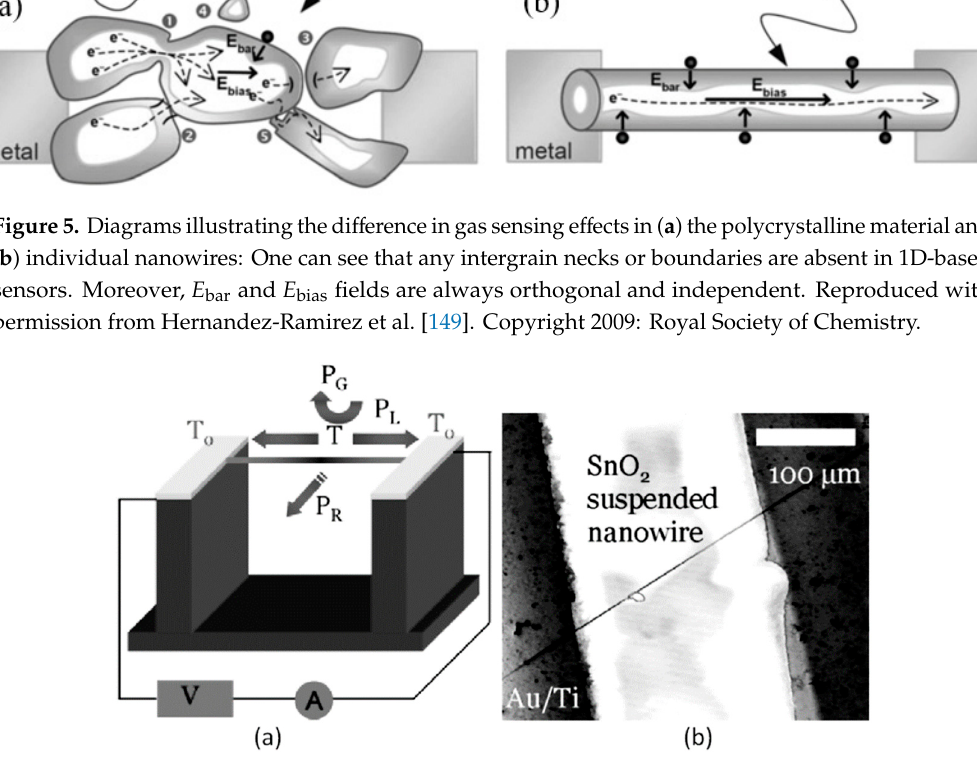
Figure 7. Estimated temperature of the devices at different I m . (r nw ~35 nm) (inset) SEM image of a SnO 2 nanowire connected to two Pt microelectrodes fabricated with a focused ion beam. The equivalent circuit of this structure corresponds to two back-to-back diodes in a series with the nanowire resistance. These three components dissipate electrical power and contribute to the self-heating of the device. Reproduced with permission from Prades et al. [169]. Copyright 2008: American Institute of Physics. In addition, self-heating effects enable an experimental methodology to improve the selectivity of metal oxide-based sensors. It was found that the thermal response time of these devices, due to a small thermal inertia, is very short—only a few milliseconds. [172]. This enables the use of higher modulation frequencies of their temperature profile, making available the direct observation of the kinetics associated with the chemical interactions between the metal oxide and the gases of interest